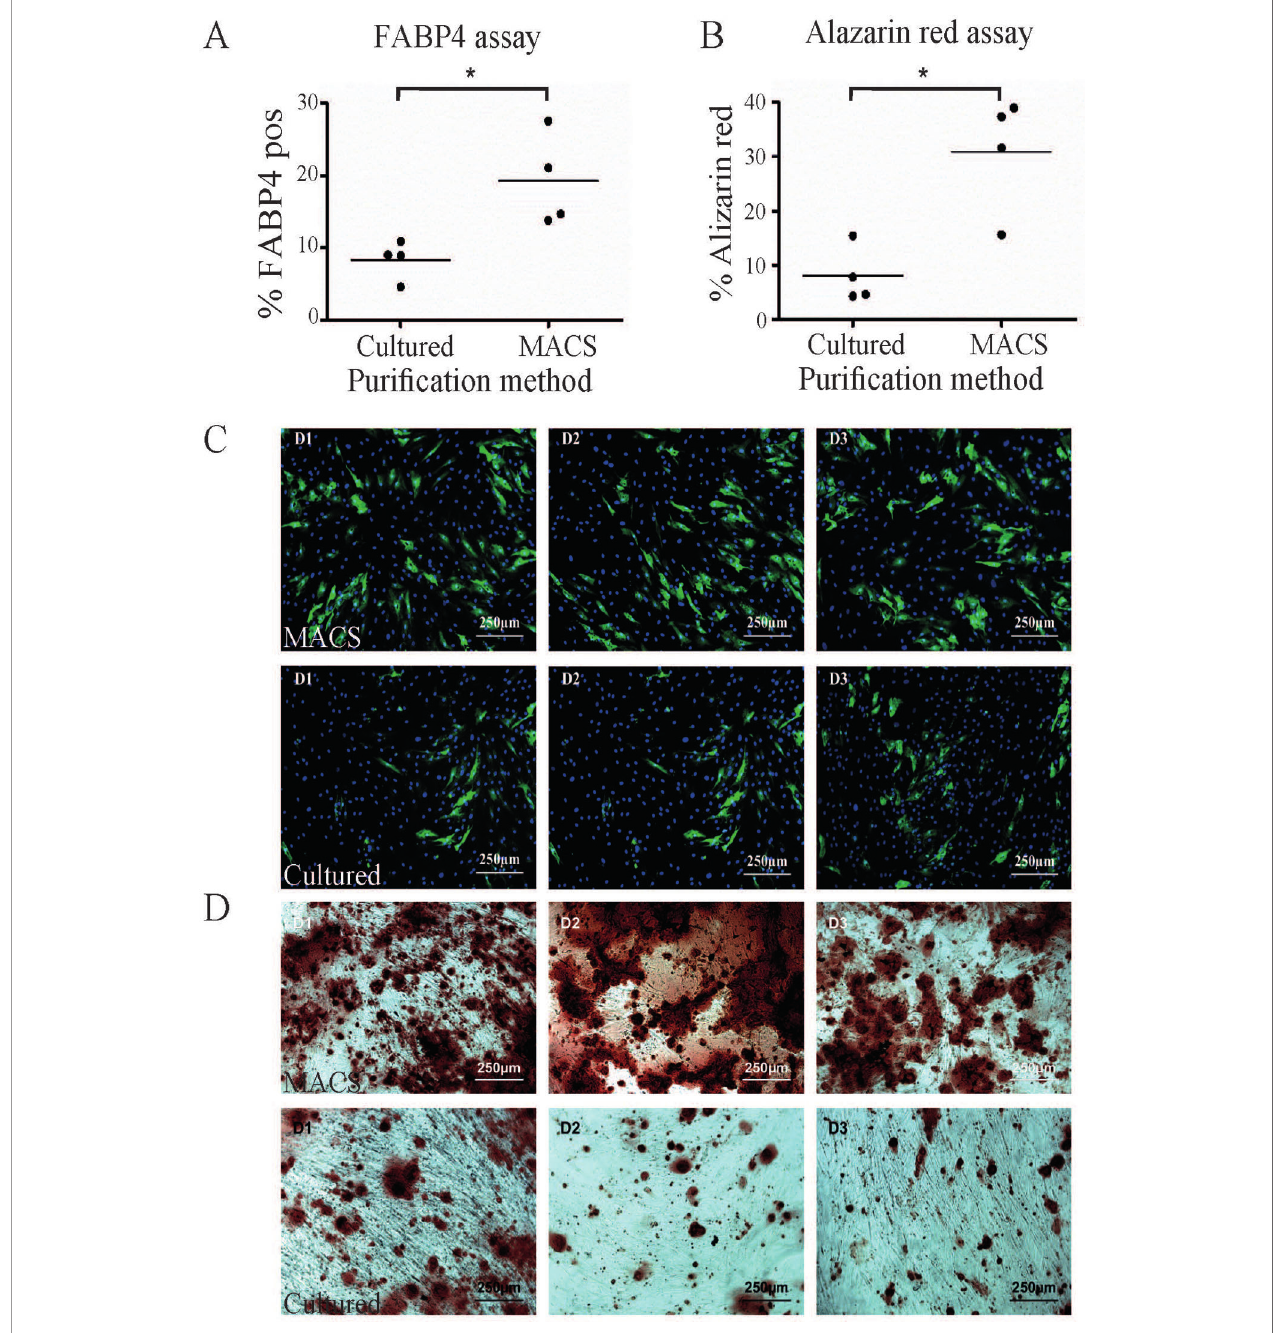
FIGURE 2 | A greater proportion of MACS-derived adipose-derived stem cell (ASC) exhibit activity in in vitro differentiation assays compared to culture-derived ASC. (A) MACS-derived and culture-derived ASC were subjected to an in vitro adipogenic differentiation assay. The graph represents the percentage of cells which stained positive for FABP4 expression after quanti fi cation. Panel (C) shows representative images from the adipogenic differentiation assay for three donors (D1 – D3) where FABP4 positive cells are stained green and nuclei are stain blue. The top row contains images of MACS-derived ASC and the bottom row contains images from culture-derived ASC. The graph in (B) represents the percentage of cells which stained positive for alizarin red after 3 weeks of culture in commercial osteogeneic differentiation media. Panel (D) shows representative images from the alizarin red assay for three donors (D1 – D3). The top row contains images of MACS-derived ASC and the bottom row contains images from culture-derived ASC. * denotes a p value of <